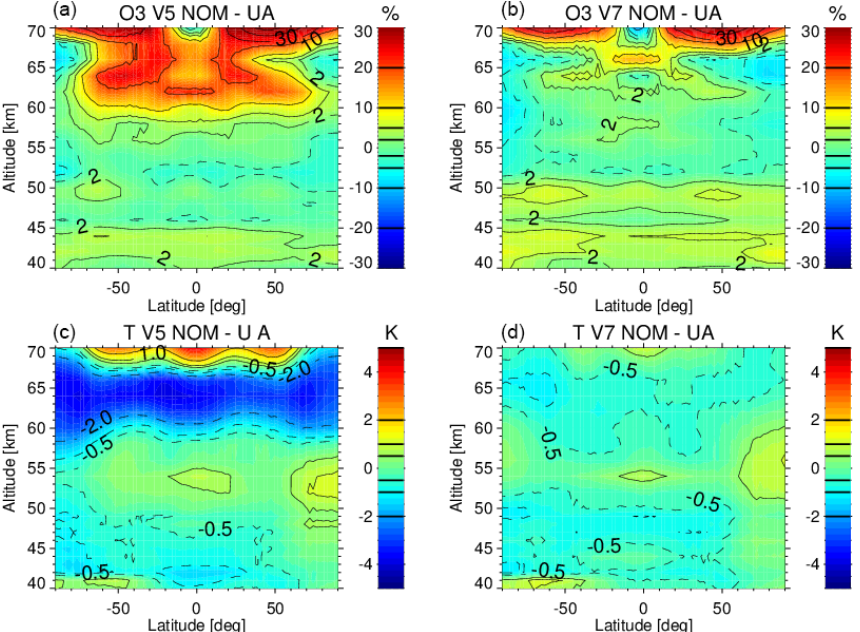
Figure 1. Climatological mean differences of ozone (a, b) and temperature (c, d) retrievals from the old (a, c) and new (b, d) versions of data from retrievals from MIPAS middle and upper stratospheric